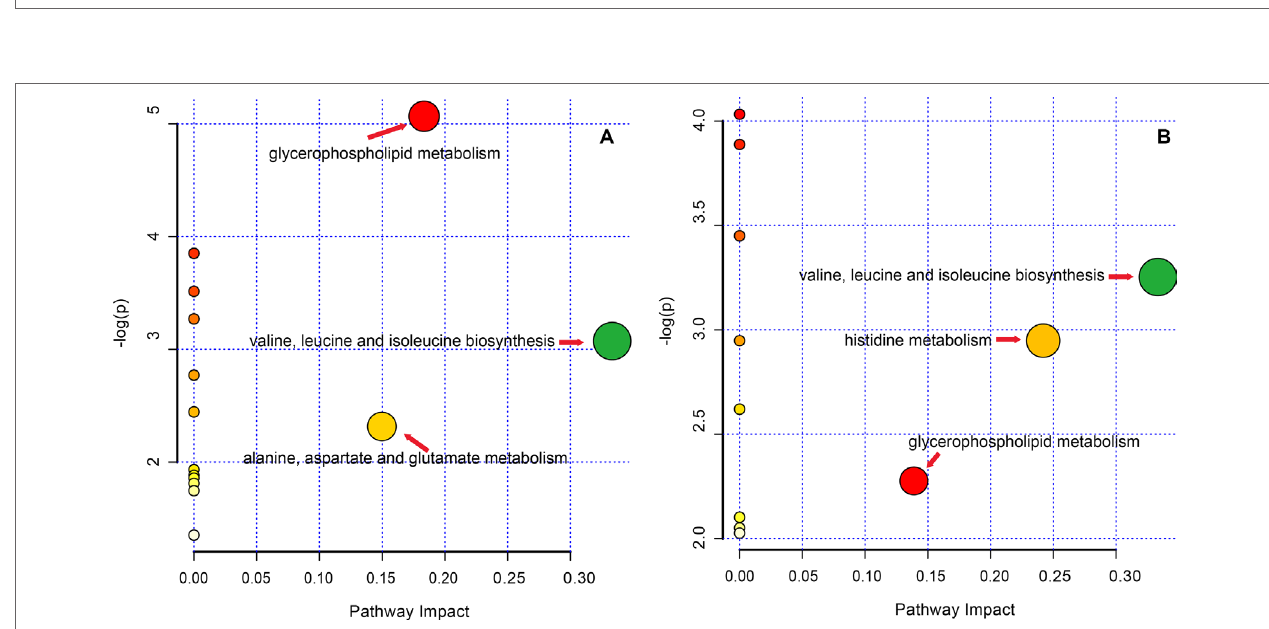
FIGURE 7 | Pathway analysis in rats with ethanol-induced gastric lesions treated with GF and GFC. (A) (GF group); (B) (GFC